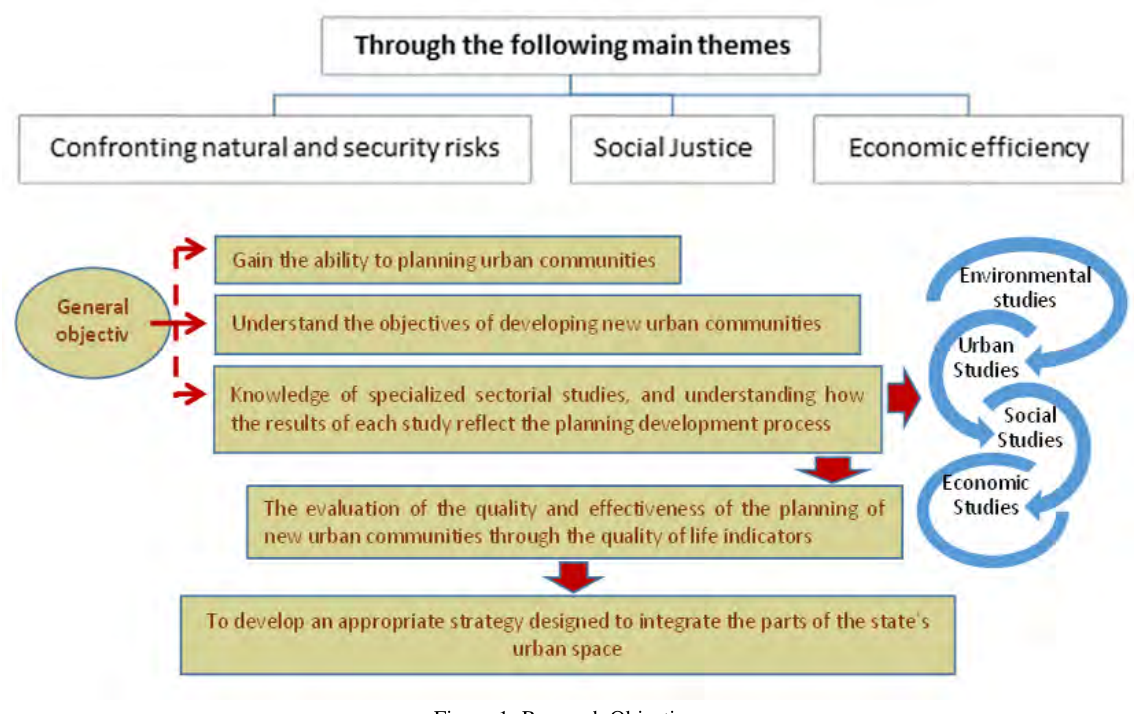
Figure 1. Research